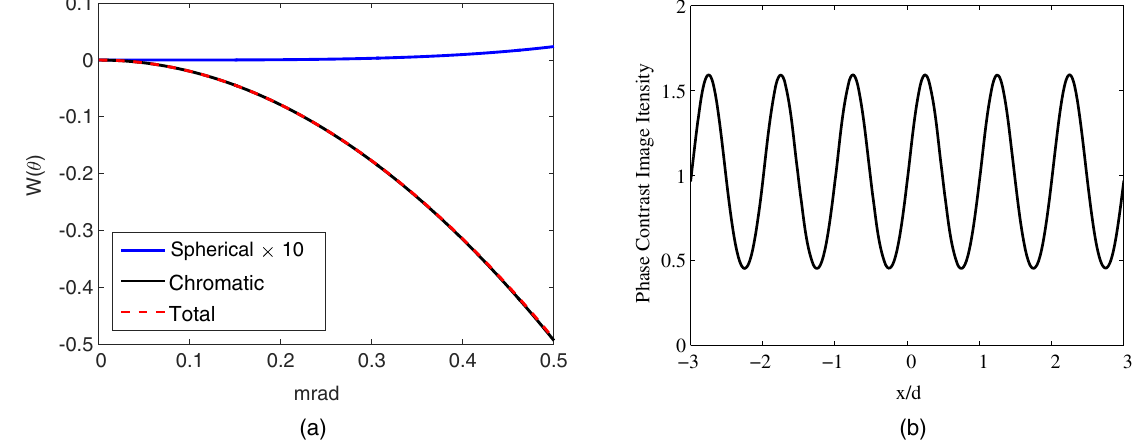
FIG. 11. (a) Added phase as a function of the angle of divergence for a focal length of 4 mm and a Δ E=E ¼ 1 . 3 × 10 − 5 . (b) Electron population in phase-contrast image propagated through a lens with a focal length of 4 mm for the initial conditions in Fig.